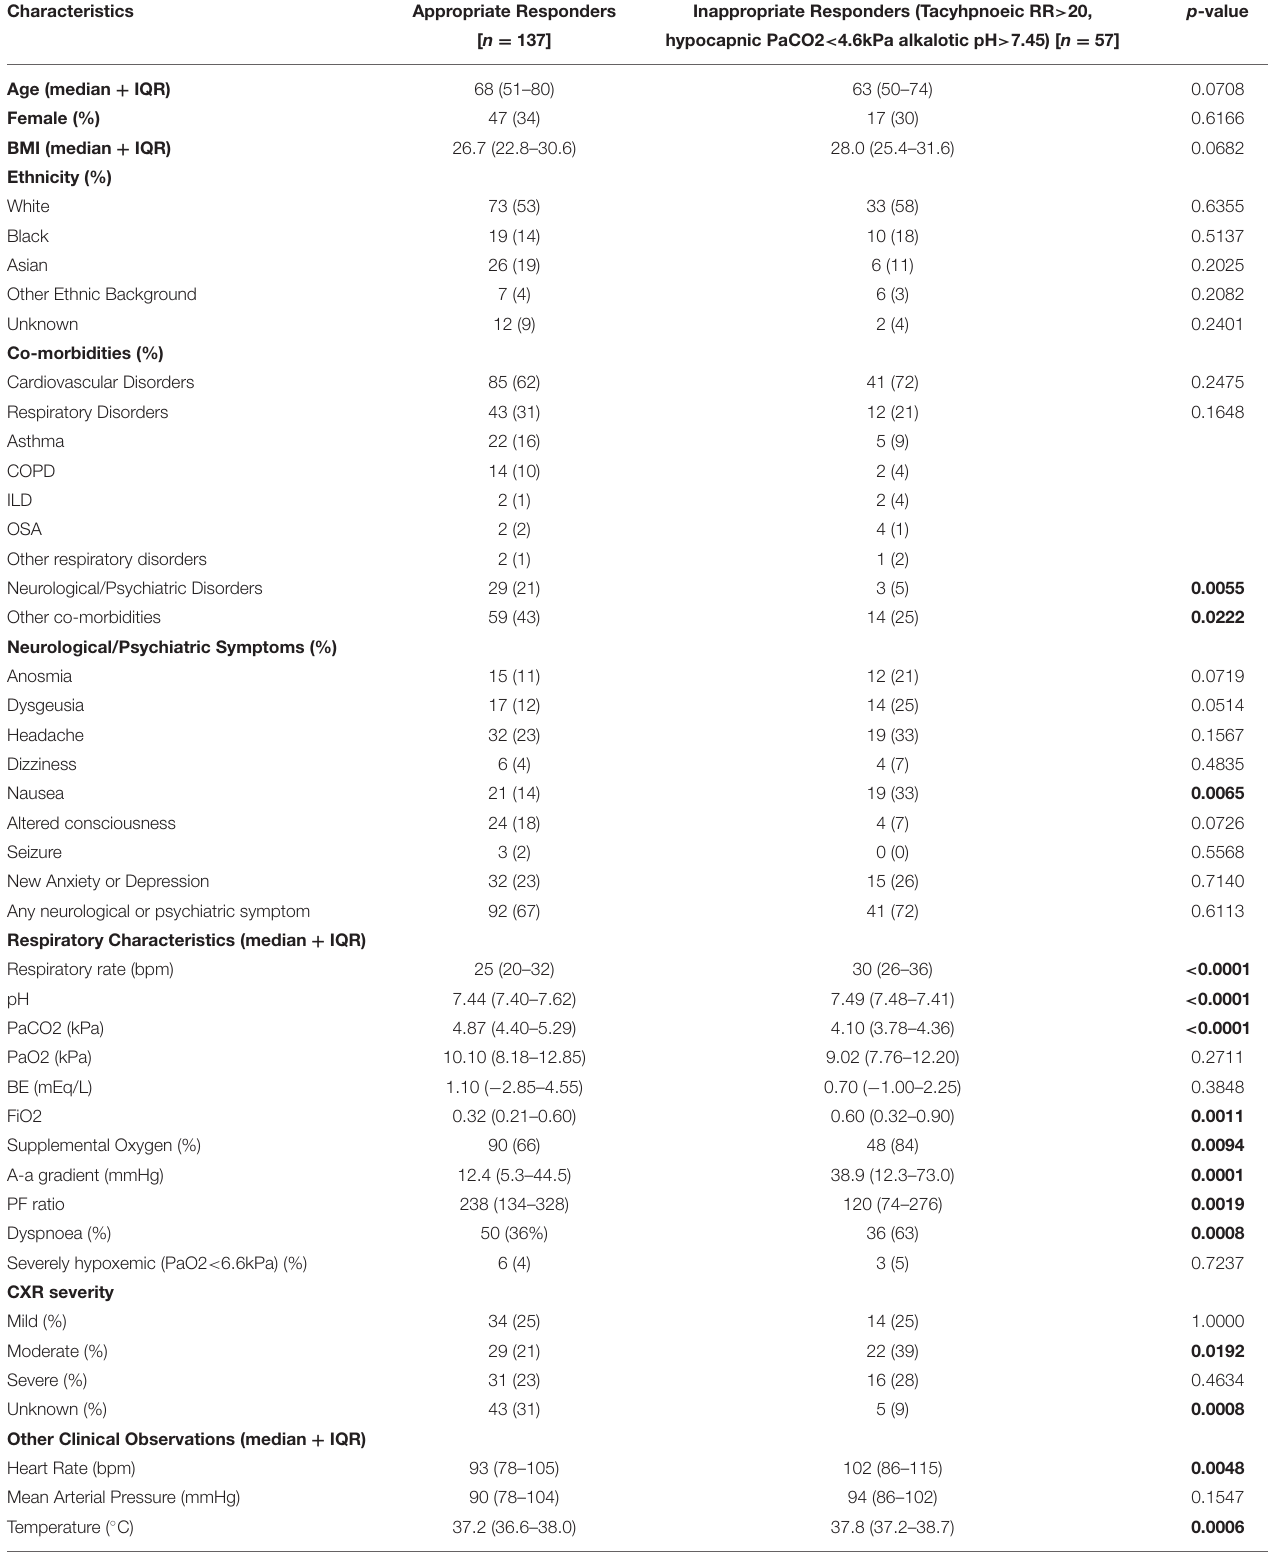
TABLE 2 | Characteristics of appropriate vs inappropriate responders.